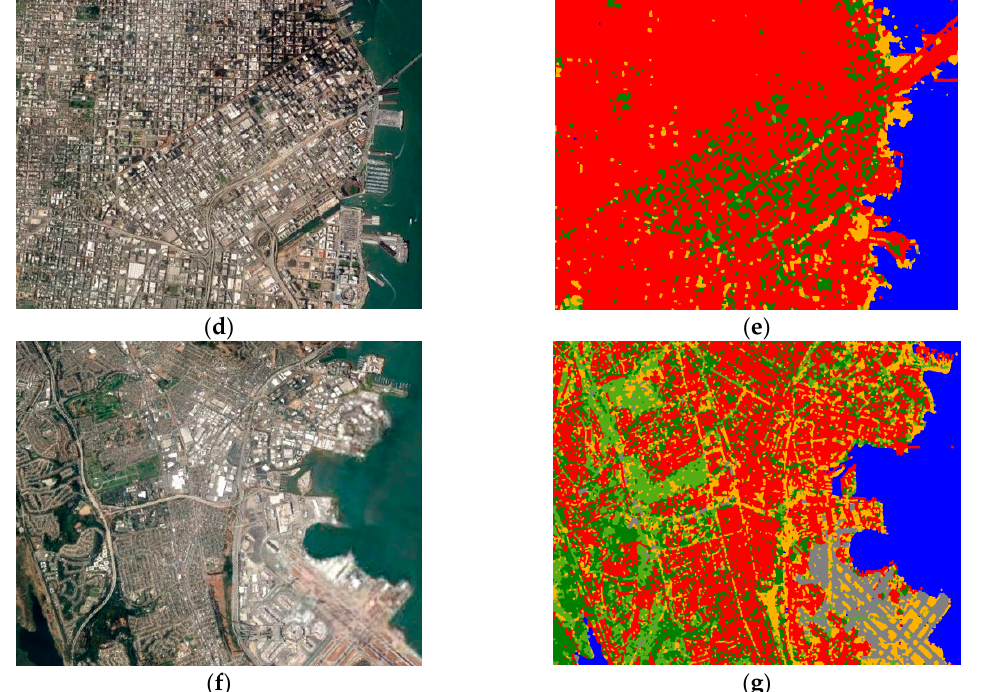
Figure 11. ( a ) Google Earth image of the mountain; ( b ) the corresponding Pauli-basis image; and ( c ) the corresponding classification result; ( d ) Google Earth image of oriented buildings where the intensity of the horizontal vertical channel was high; and ( e ) the corresponding classification result. ( f ) Google Earth image of the urban area around the airport; and ( g ) the corresponding classification result.